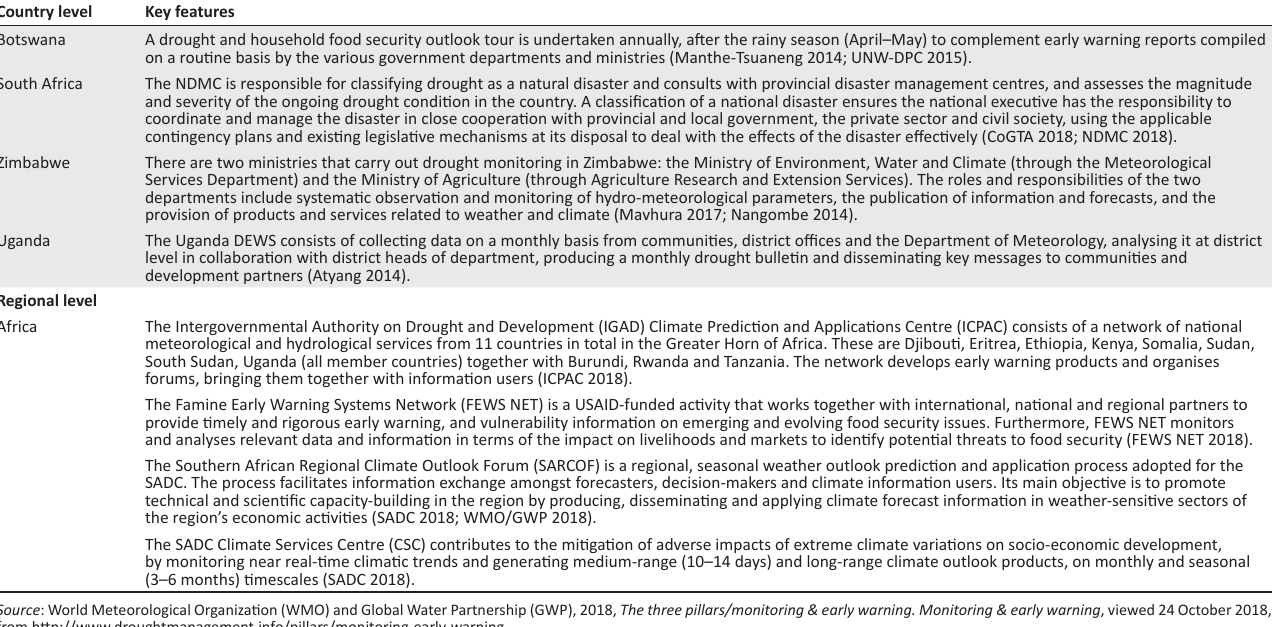
TABLE 3: Review of country and regional drought monitoring